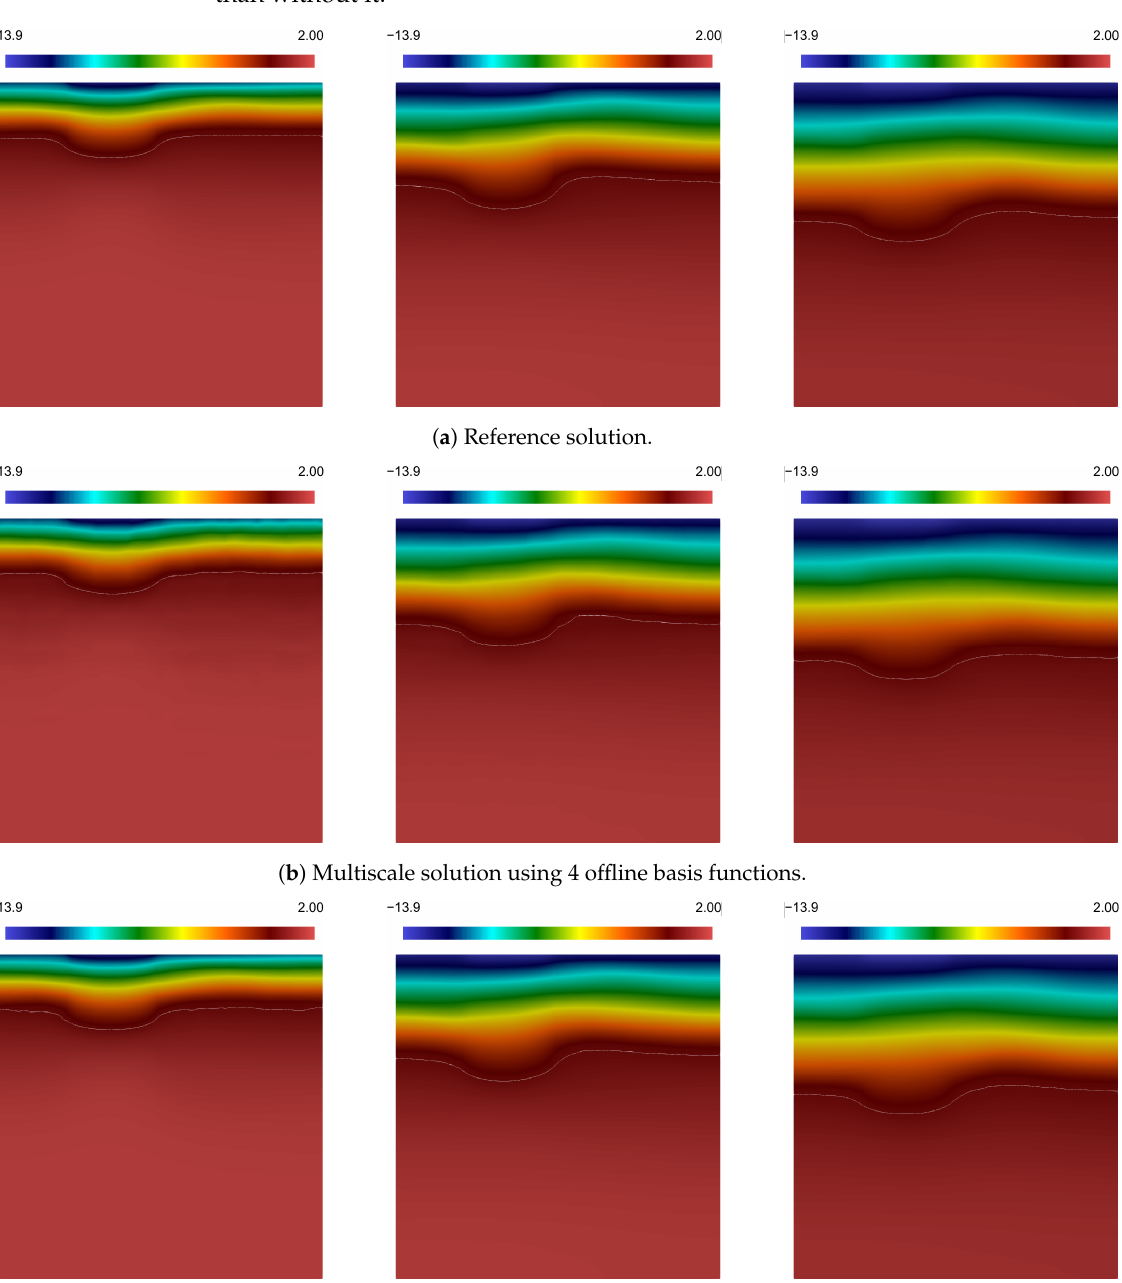
Figure 9. Distributions of T at t n , n = 10,30,50 (from left to